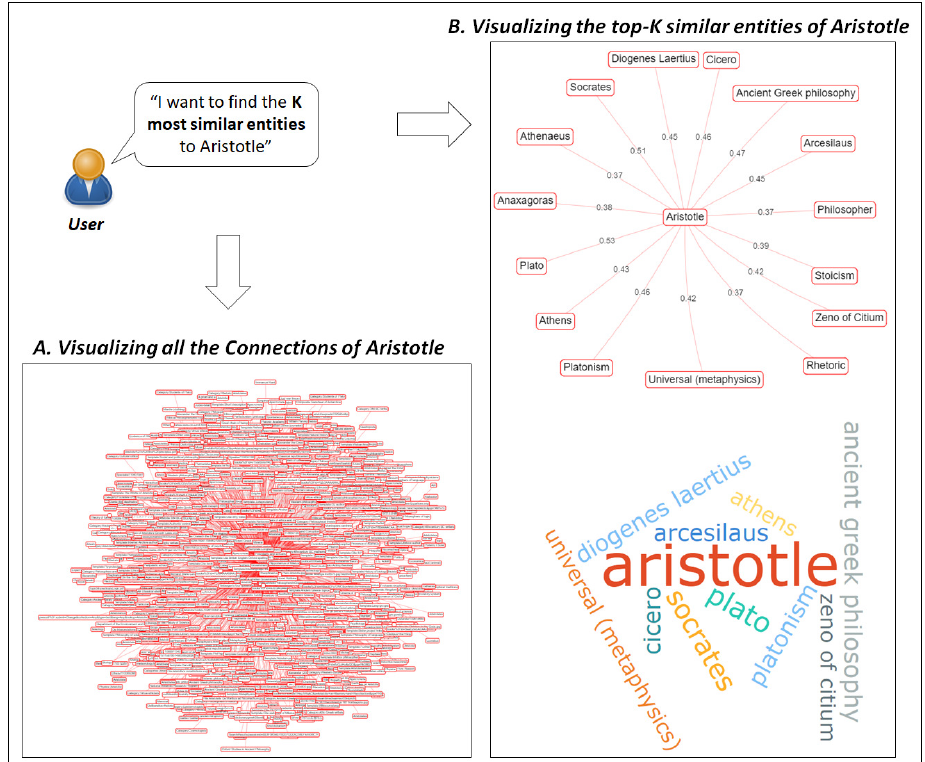
Figure 13. Discovering Similar Entities for the selected entity